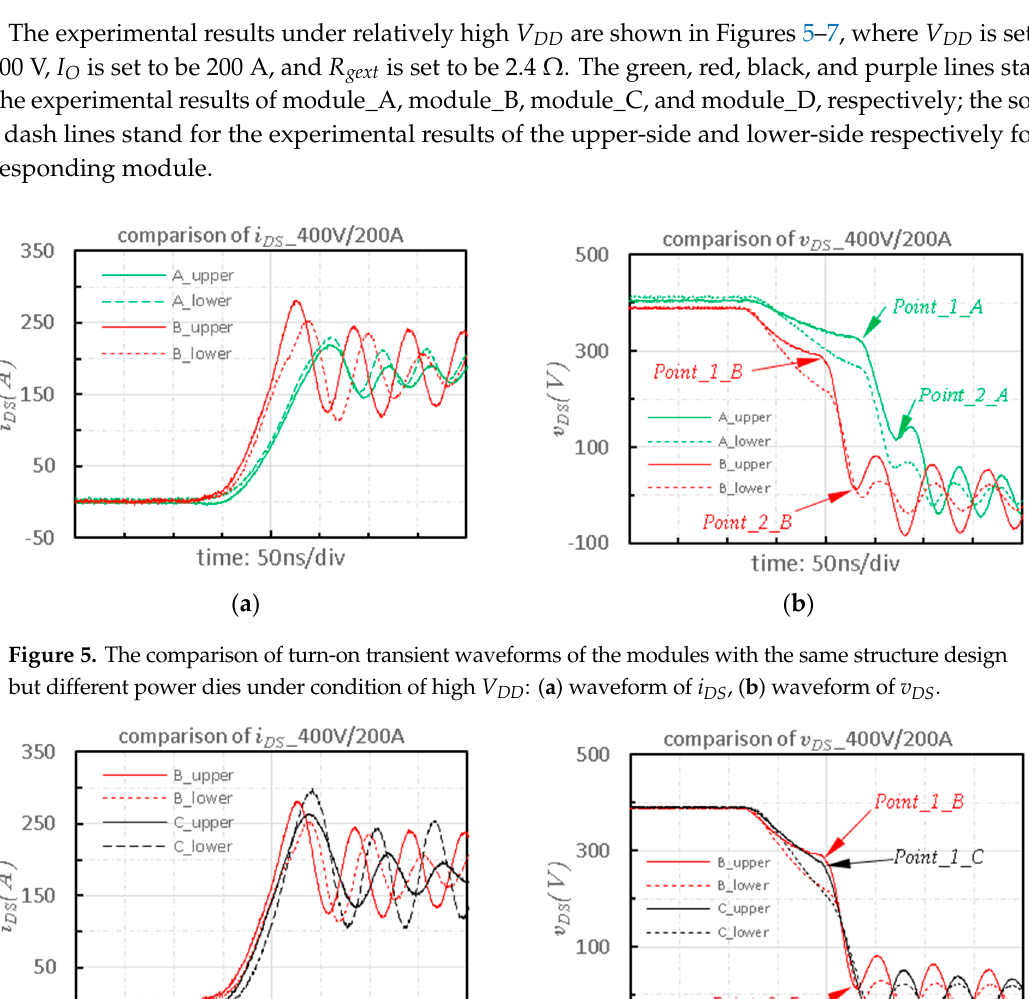
Figure 6. Comparison of turn-on transient waveforms of the modules with different structure design but same power dies under condition of high V DD : ( a ) waveform of i DS , ( b ) waveform of v DS .